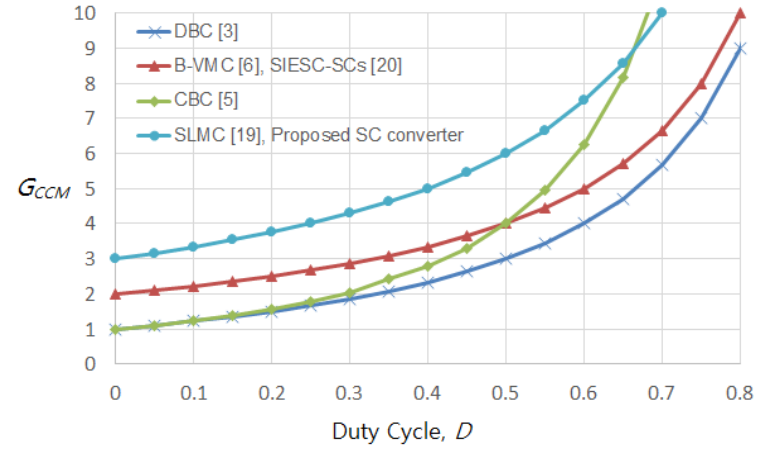
Figure 8. Voltage gain comparison with other non-isolated converters.